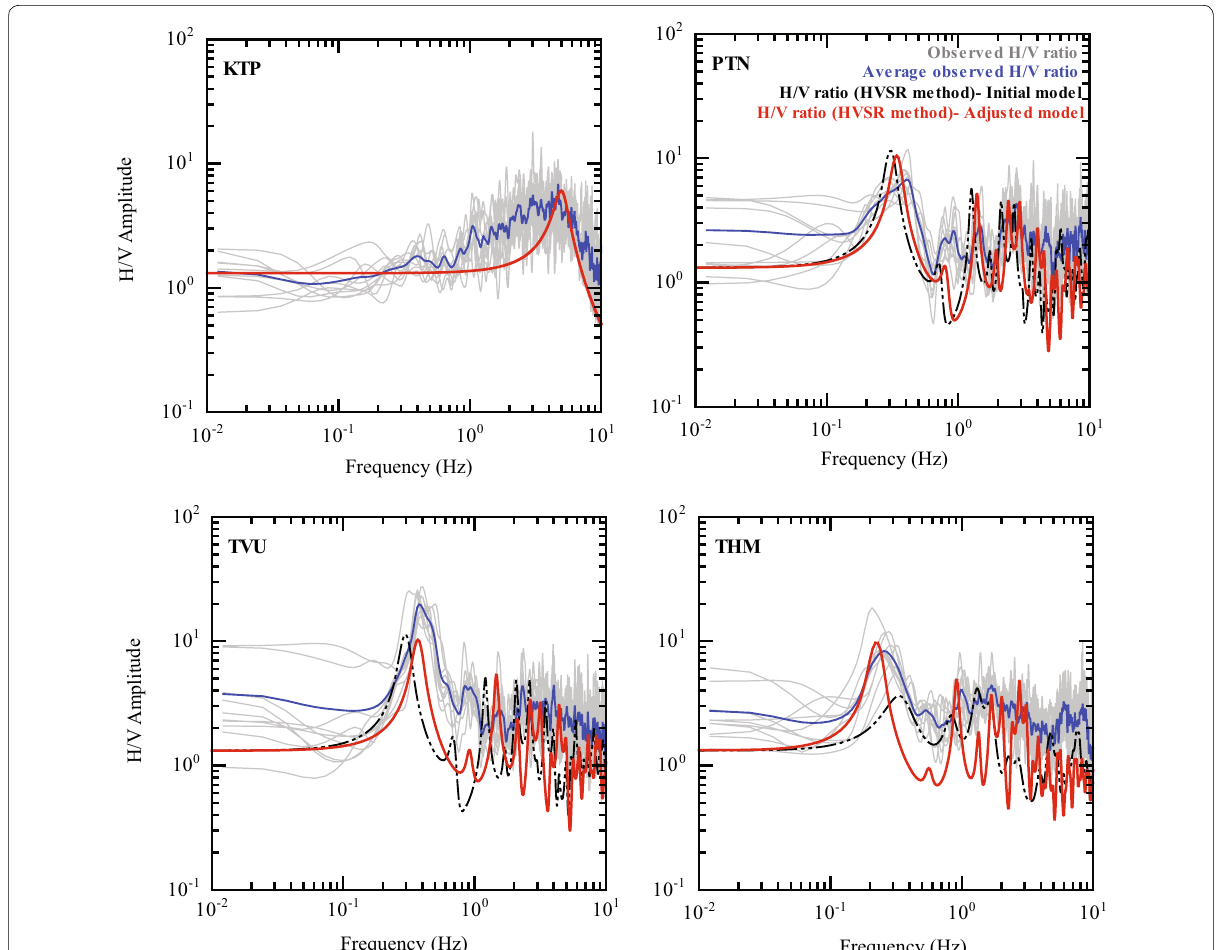
Fig. 12 Comparison of the observed average H / V ratio with the theoretical H / V ratio. The theoretical H / V ratio was calculated using the HVSR method and adjusted 1-D velocity model. Notice the flat curve at the rock site, KTP (<1 Hz). The dashed black lines indicate the results from the initial velocity models